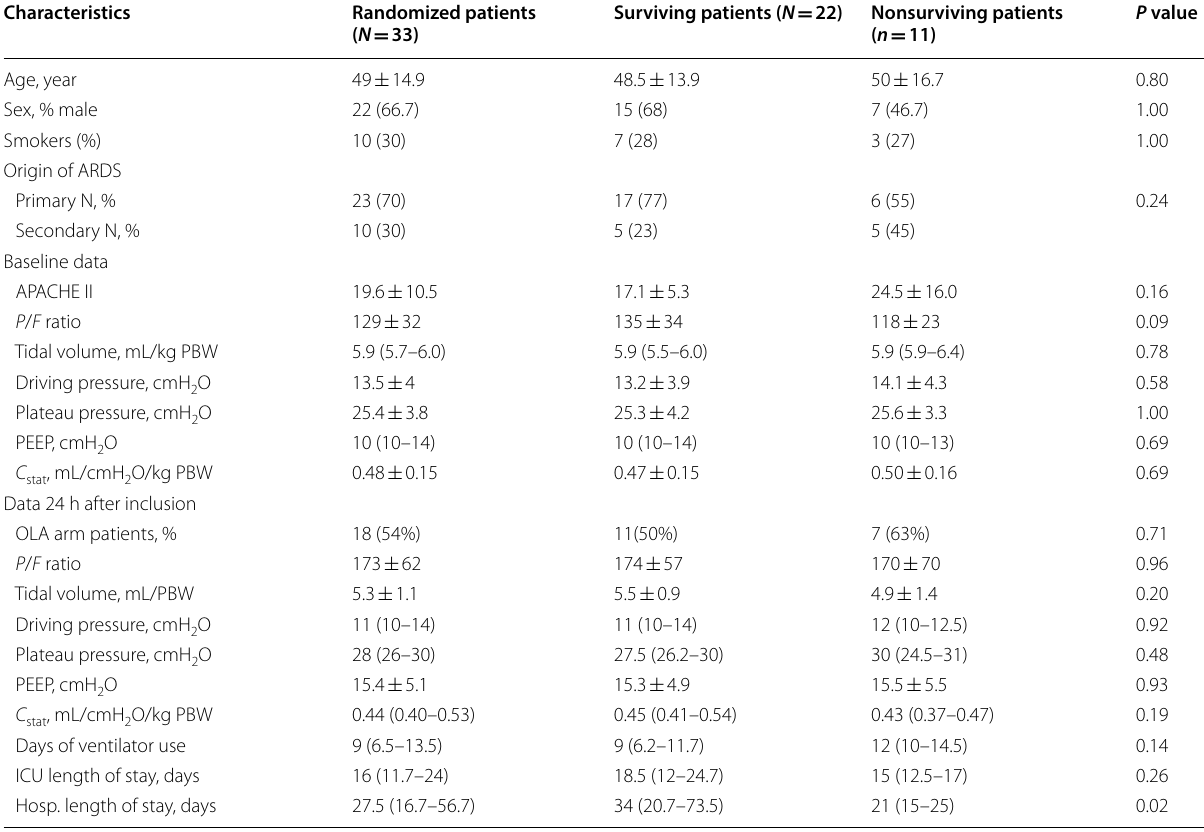
Table 1 Demographic characteristics and mechanical ventilation variables from randomized and surviving ARDS patients